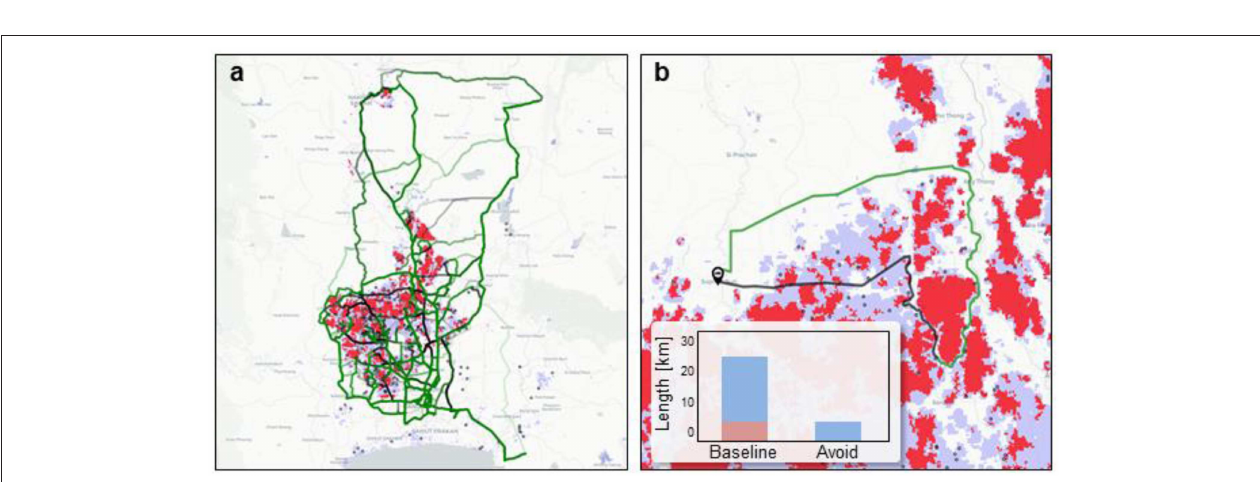
FIGURE 7 | (a) Geographic distribution of routes under baseline conditions (black) and with advance Earth observations (green) with opacity indicating density of routes. (b) Example of single route combination. Inset graph shows relative lengths of Flooded and Highly Flooded roads (blue and red shading, respectively).